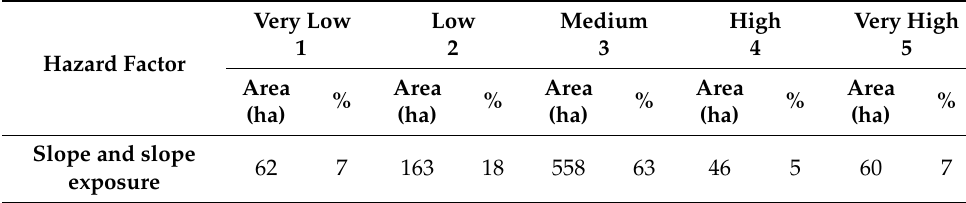
Table 24. Areas and percentages of the study area classified as each class of the slope and slope exposure hazard